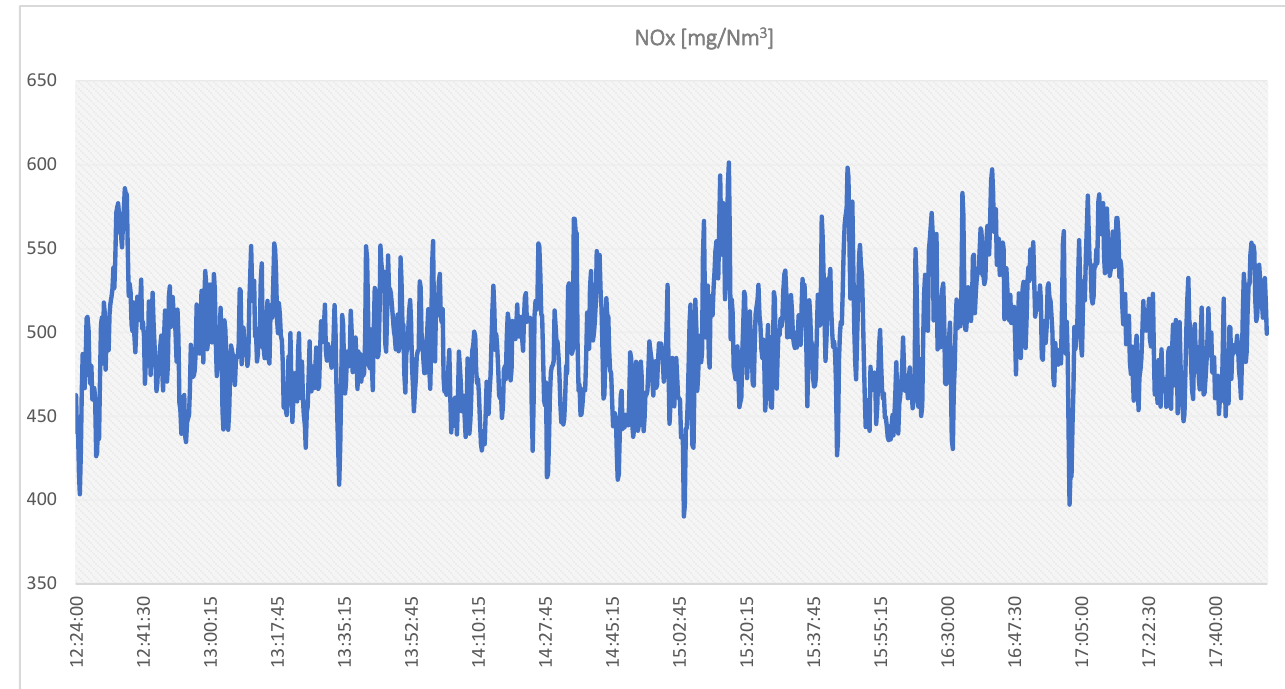
Figure 3 . CO emission trend during combustion test .